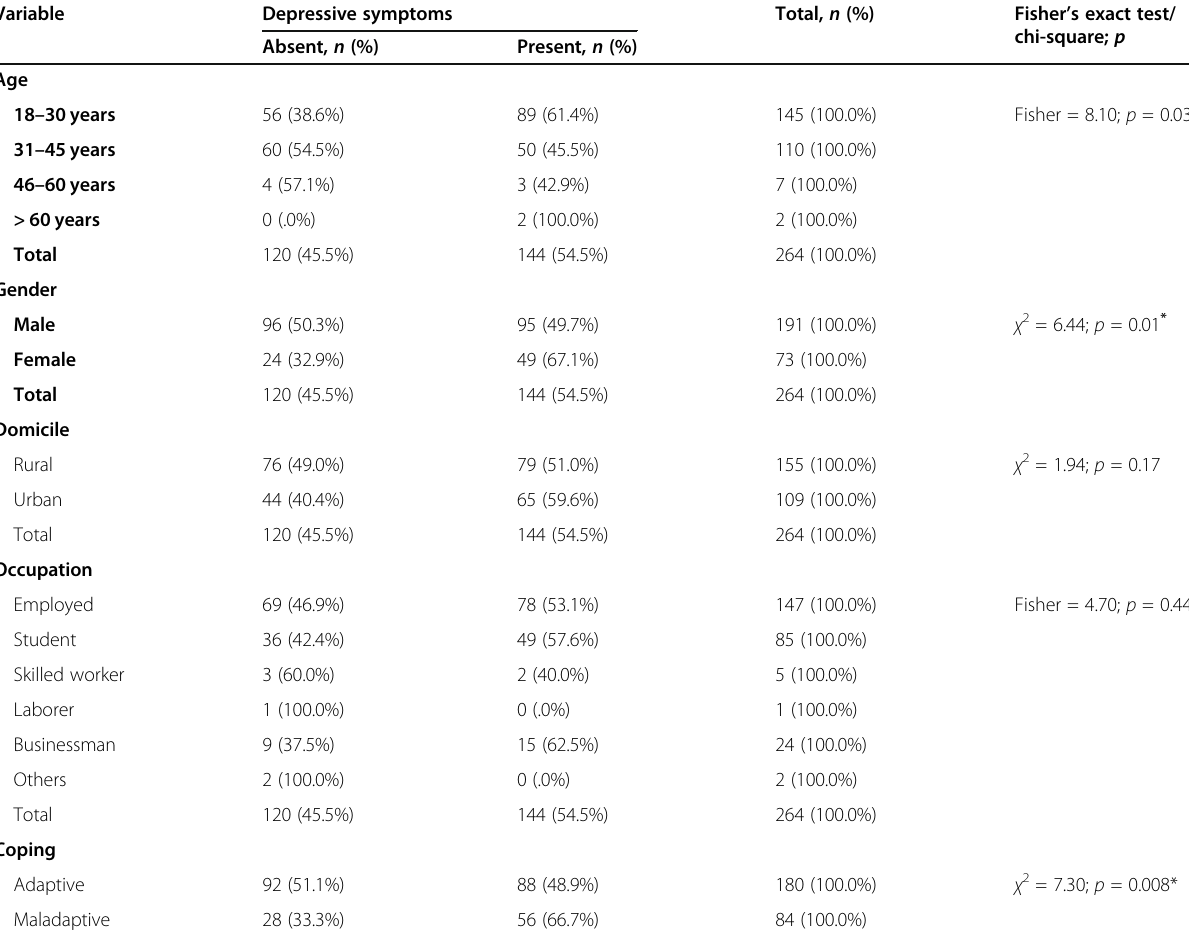
Table 3 Socio-demographic variables in relation to Depressive Symptoms ( N = 264)